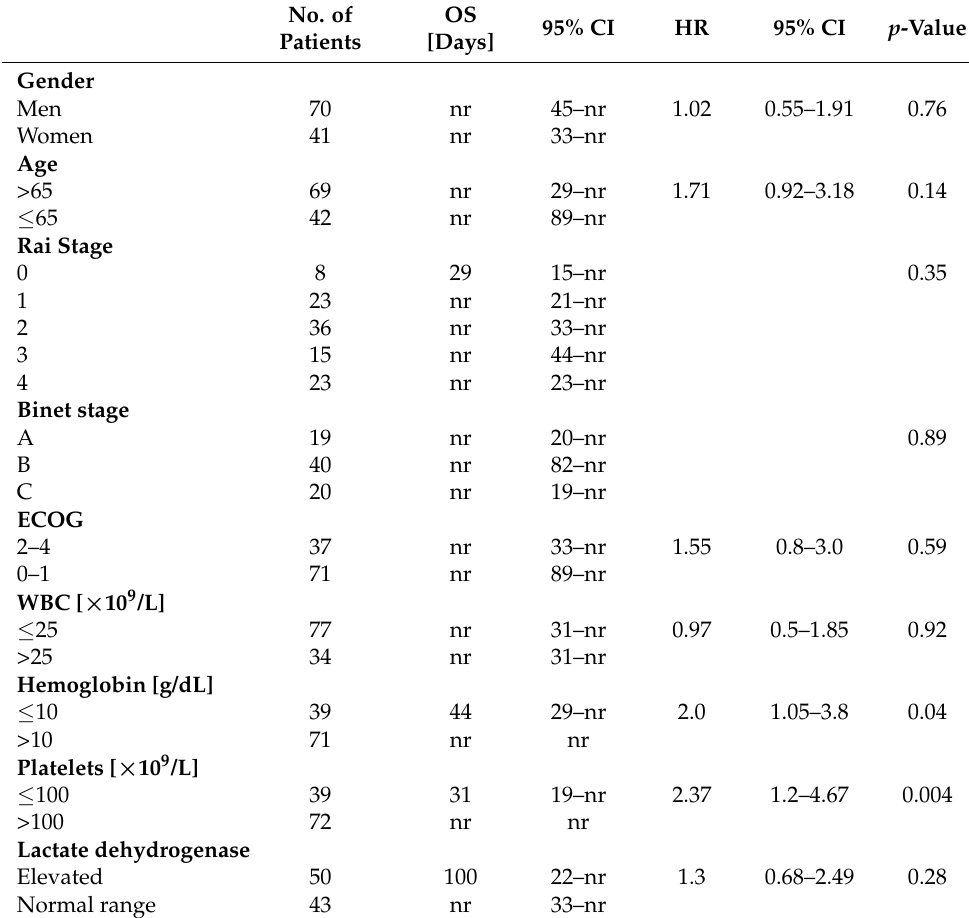
Table 3. Overall survival of hospitalized